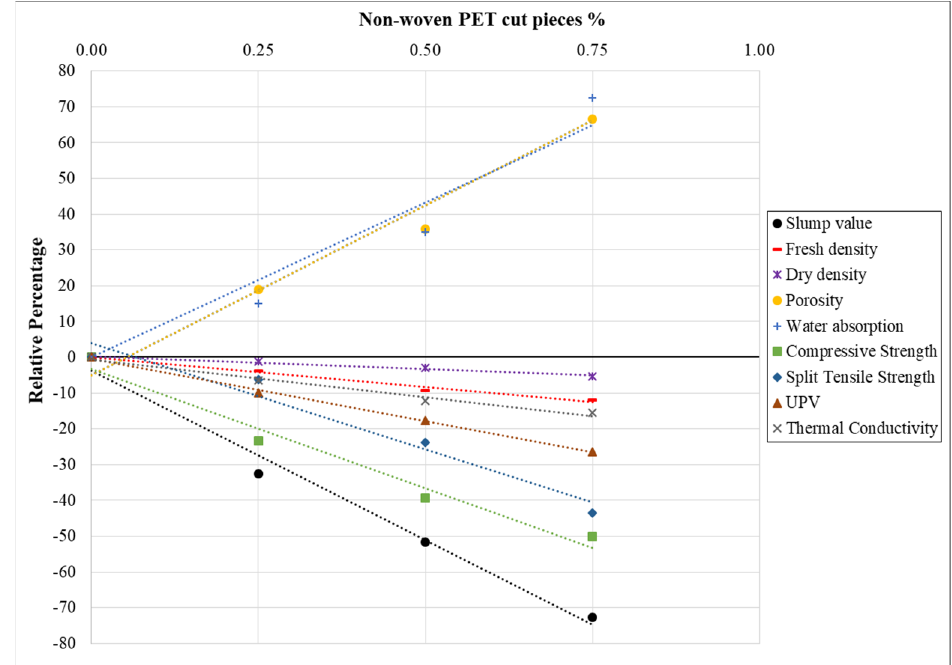
Figure 32. Relationship between percentages of non-woven cut pieces and various properties of concrete .